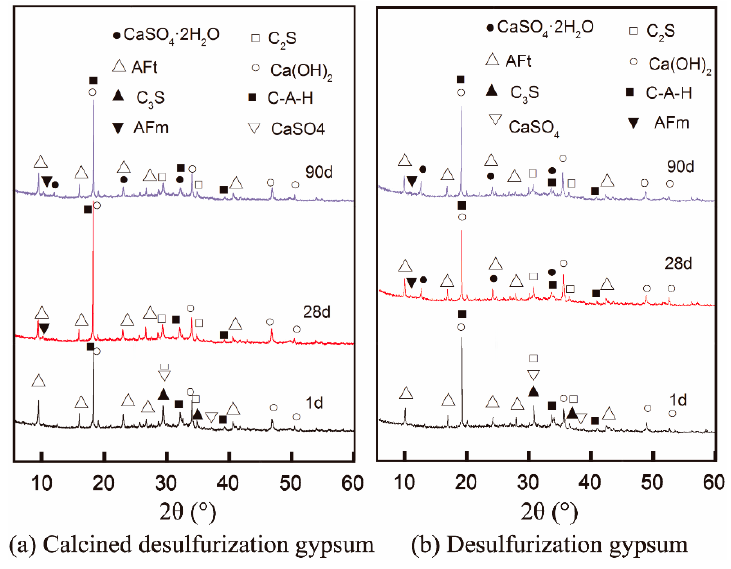
Figure 8. XRD pattern of sample F1 and F2 in standard curing for 1, 28, and 90 days.